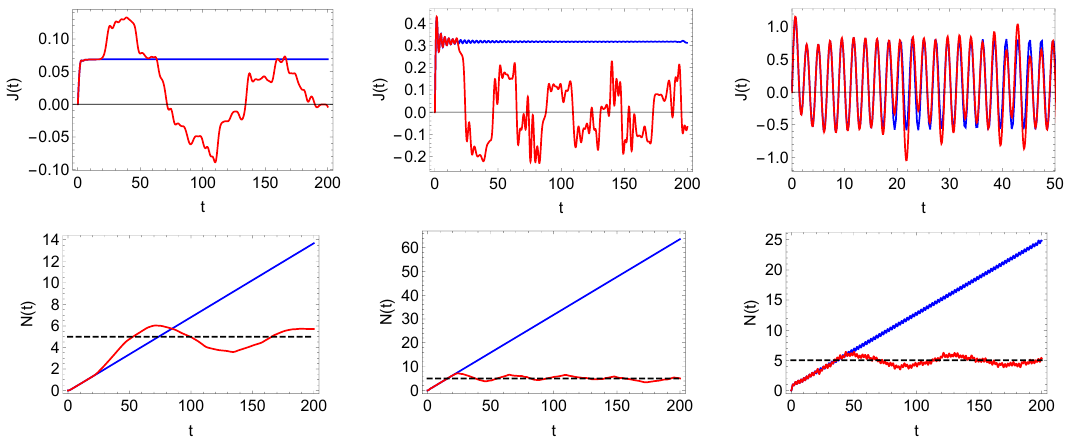
Figure 2: The current through the link (upper panels) and the number of particles in the right chain (lower panels) for (cid:34) = 0.3 (left), (cid:34) = 1.0 (center) and (cid:34) = 2.4 (right). Red curves correspond to numerical results for the initially fully filled left chain ( N = 10 fermions). The current (86) in the thermodynamic limit is shown by blue solid lines. The black dashed lines in lower panels indicate the half of the initial number of particles. Notice the change of the time scale in the upper left